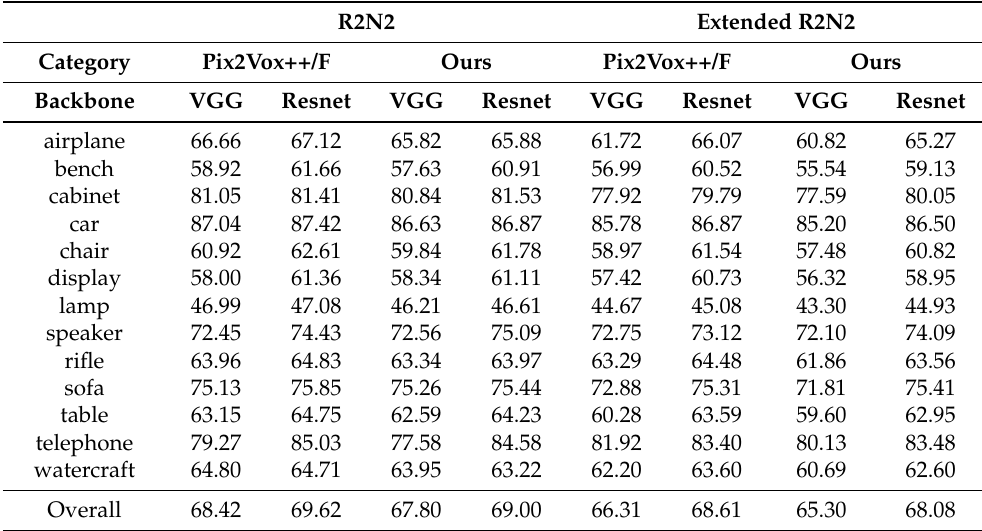
Table 2. Comparison of IoU per category, obtained from 8 views selected from the original or extended R2N2 dataset. We took the mean for all objects in the test set per